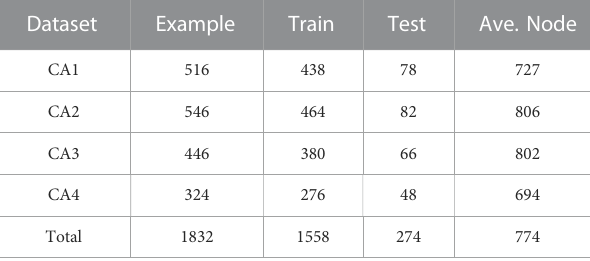
TABLE 2 Summary of the four datasets used in our